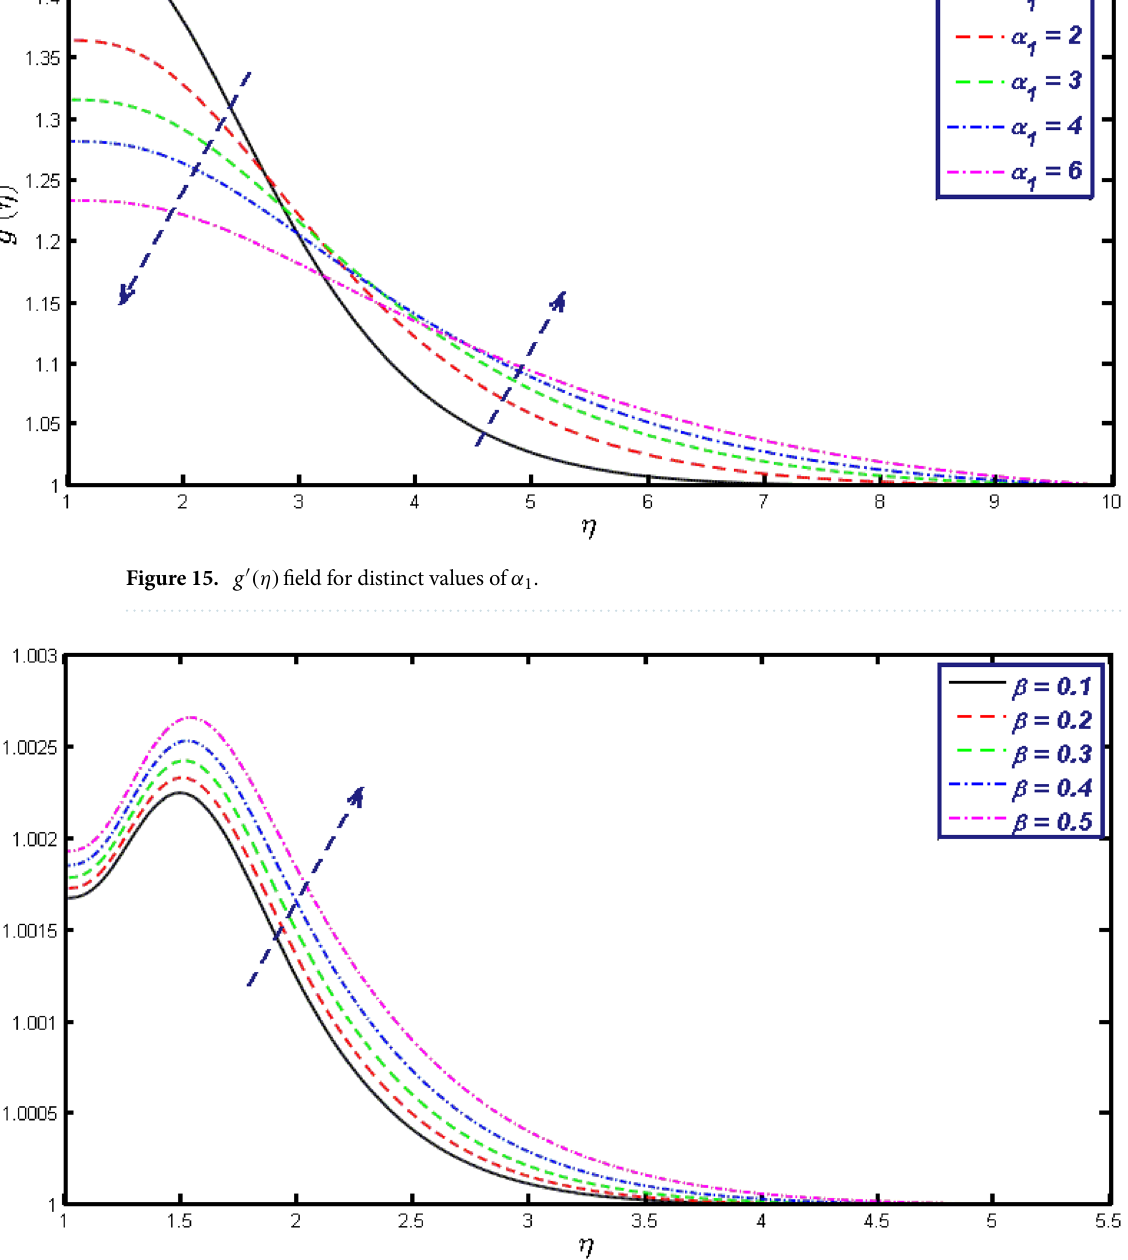
Figure 16. g ′ (η) field for distinct values of β